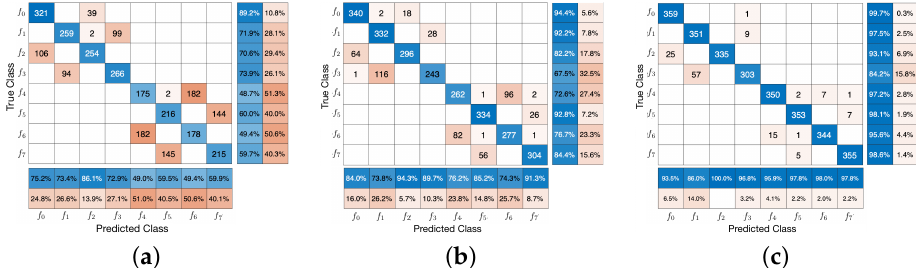
Figure 7. Confusion matrix of SVM ( a ), the CNN ( b ), and CNN–TL with various fault types, f 0 , . . . , f 7 ( c